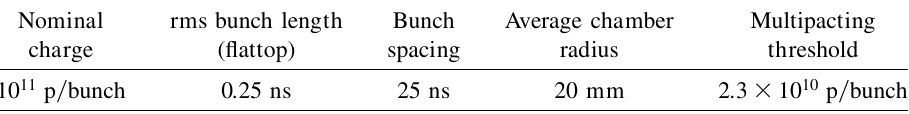
TABLE I. Nominal parameters for the LHC beam and chamber, and estimated proton intensity threshold to produce electron multipacting. Updates for these parameters can be checked at